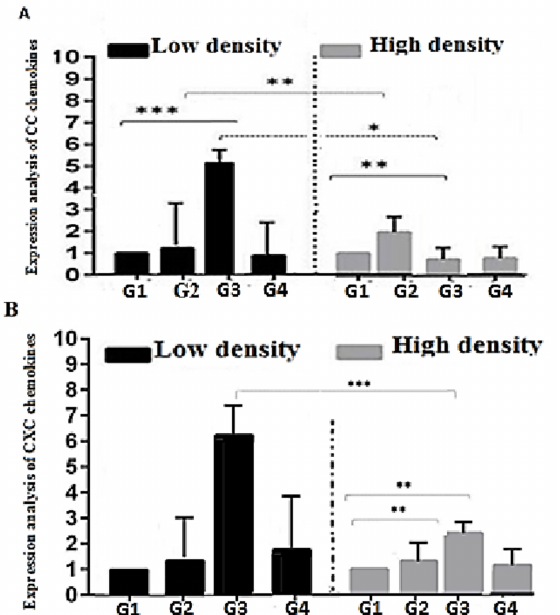
Figure 1. Relative expression of some inflammatory-related genes (CC-chemokines ( A ) and CXC- chemokines ( B )) in Low and High stocking density of Nile tilapia ( Oreochromis niloticus ) with dif- ferent treatment. All values are expressed as Mean ± SE. Asterisks on the data bars indicate when p < 0.05 (*), p < 0.005 (**), and p < 0.0005 (***). G1 (control without carbon source), G2 (treated with glycerol as a carbon source), G3 (treated with molasses as a carbon source), and G4 (treated with starch as a carbon source).